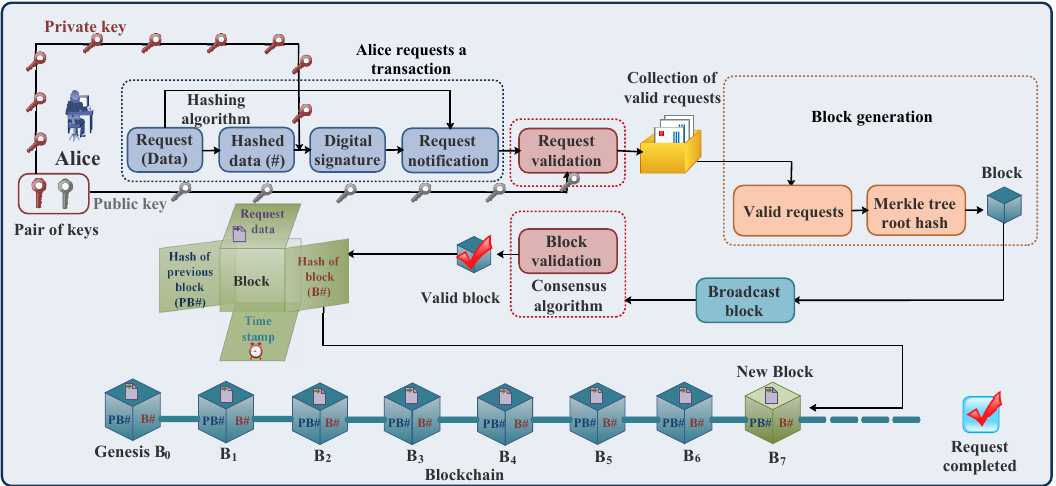
Figure 1. Process of